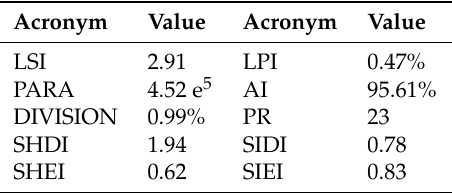
Table 4. Seascape metric values obtained for the total coral reef area surveyed. The metrics reported include: Landscape Shape Index (LSI), Large Patch Index (LPI), Perimeter Area Ratio (PARA), Aggregation Index (AI), Division Index (DIVISION), Patch Richness (PR), Shannon’s Diversity Index (SHDI), Simpson’s Diversity Index (SIDI), Shannon’s Evenness Index (SHEI) and Simpson’s Evenness Index